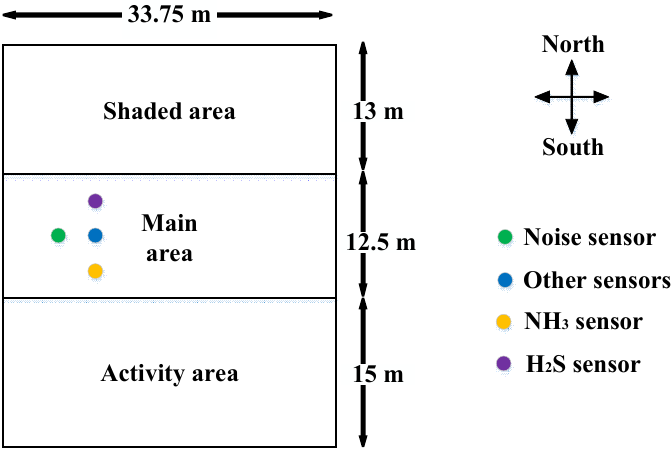
Figure 1. Schematic of the Xinjiang sheep house monitoring.